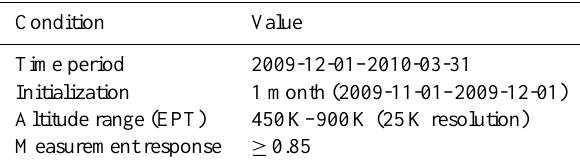
Table 2. Description of the calculations.